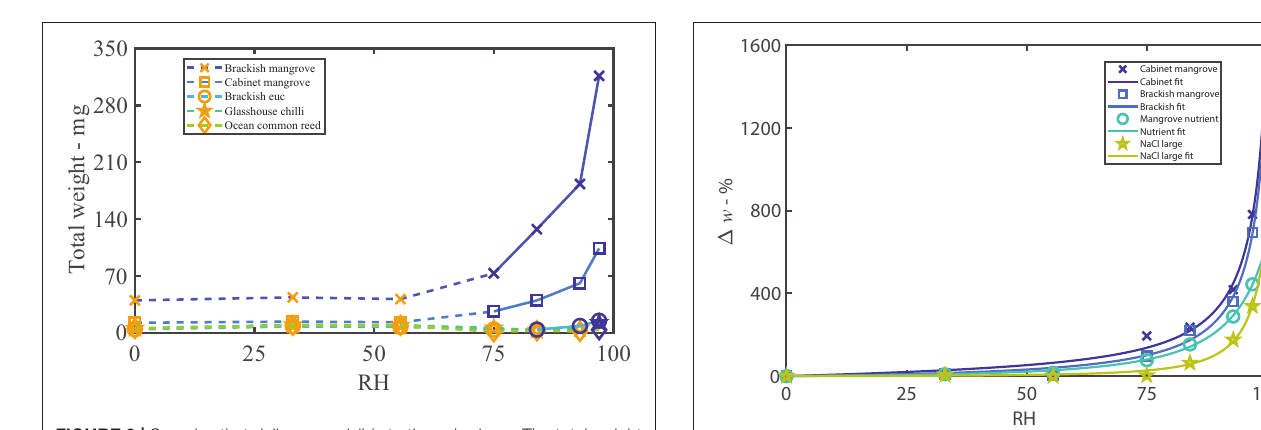
FIGURE 3 | Samples that deliquesce visibly to the naked eye. The total weight (of three repeats with the dry weight, scaled with the blank) vs. humidity (%). The orange symbols and dashed lines indicate water is not yet visible (but may have hygroscopic growth), and the blue symbols and solid lines indicate where an aqueous solution was clearly visible. Note the significant weight of the brackish mangrove sample at 97%RH of 316 mg. TABLE 5 | Dry weight per leaf area and maximum wet weight per leaf area, in µ g cm − 2 .